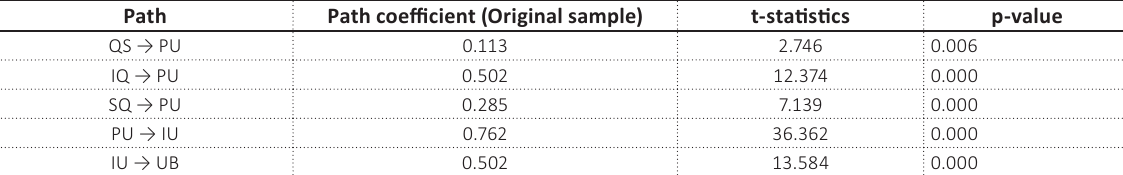
Table 5. PLS path algorithm and